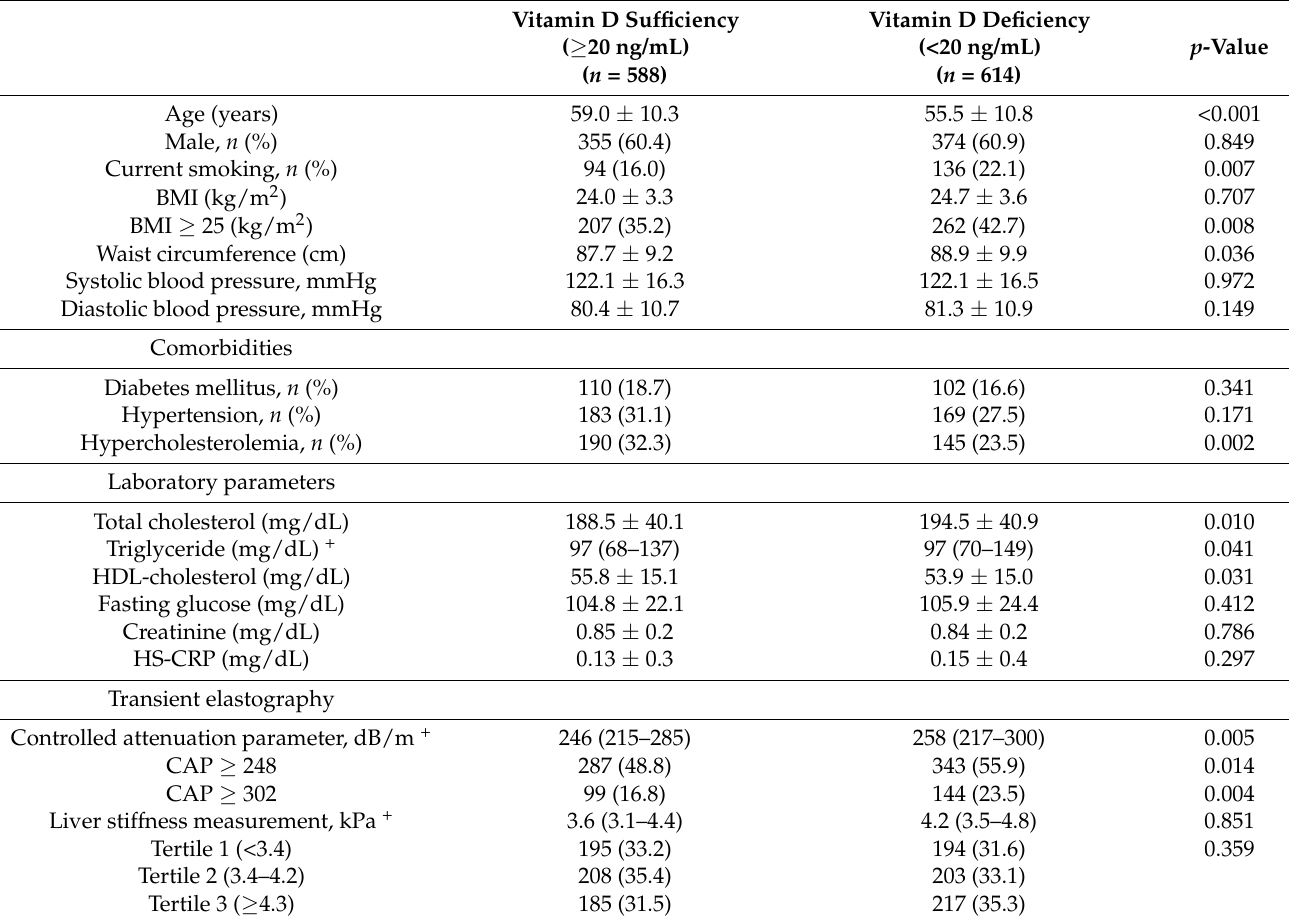
Table 1. A comparison of baseline characteristics according to vitamin D